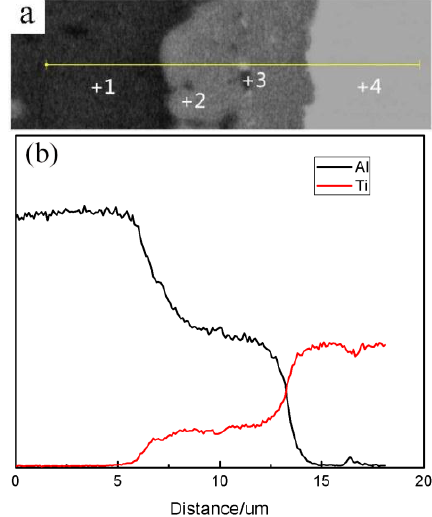
Figure 16. An SEM line and point scan analysis of the sample remelted at 640 °C for 8 h. ( a ) SEM micrograph of line and point scan; ( b ) Data analysis of line scan. Table 4. Compositions of the sample points after remelting at 640 °C for 8 h.